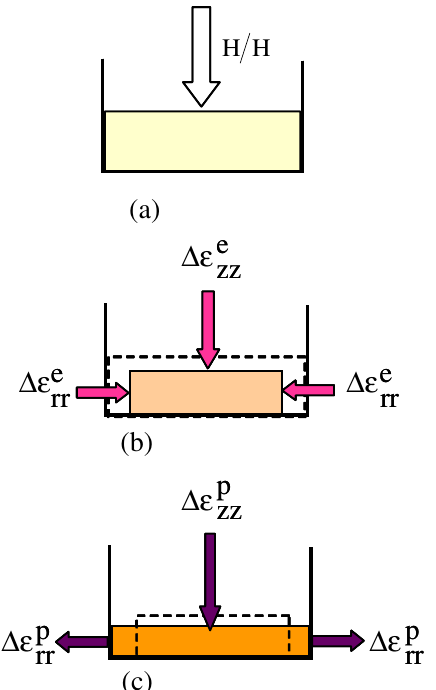
Fig. 1. Schematic view of the uniaxial strain ( ICE ) compression test. (a) Initial state. (b) Elastic strain. (c) Plastic